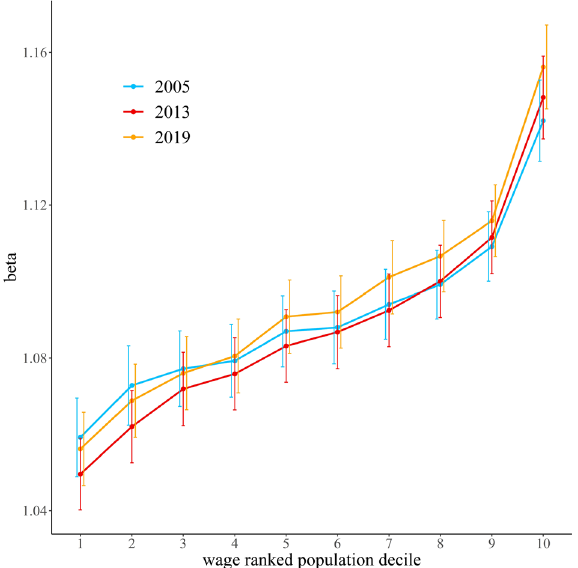
Fig. 1 Urban wage premium among U.S. metropolitan areas (MSAs) by wage ranked population decile. Deciles represent one tenth of an area ’ s population after they are ranked in order of annual wages. Each point indicates the exponent β (beta) of a single power- law regression of a decile ’ s aggregate wages versus city size. Error bars represent the standard error.